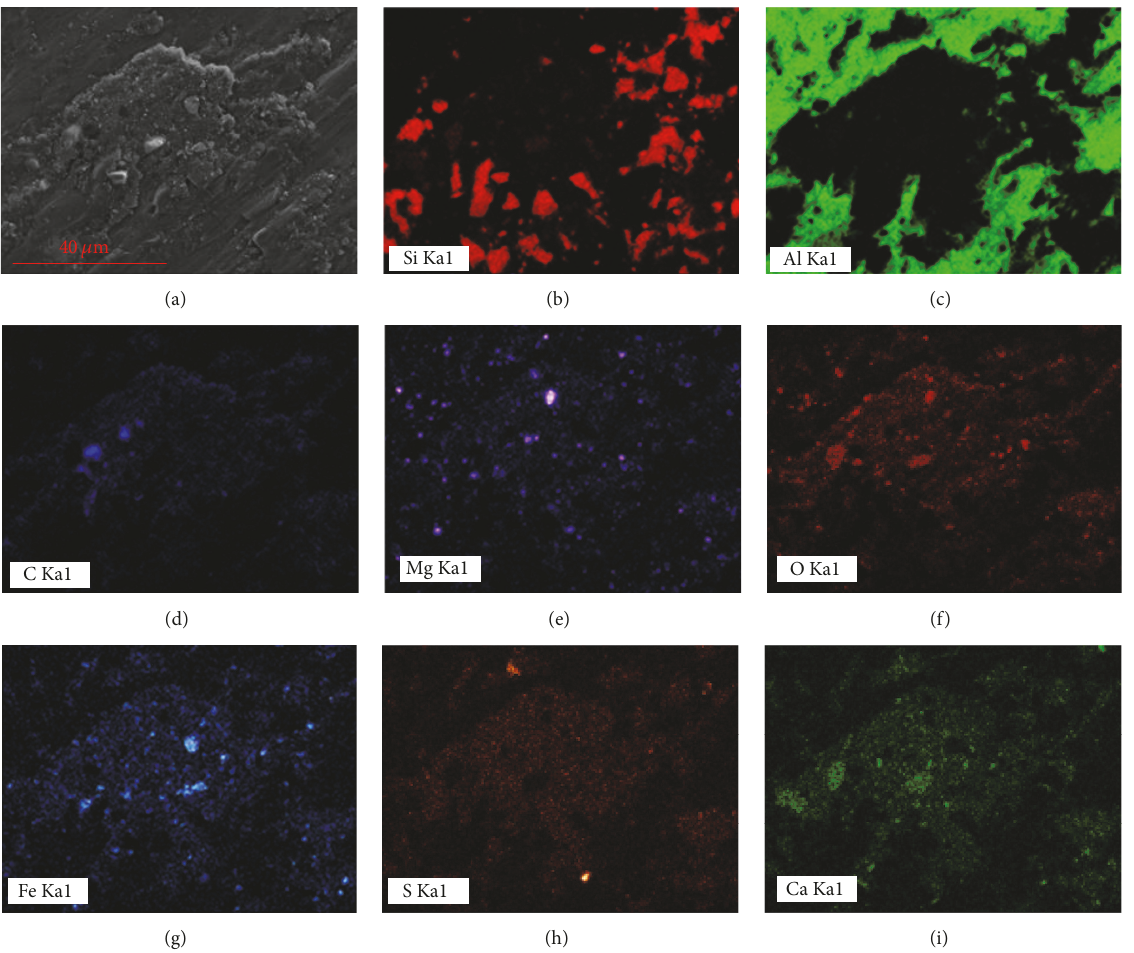
Figure 13: The surface element distribution of position P6 of composites specimen for the test of 100 ∘ C ∼ 200 ∘ C: (a) surface topography, (b) Si, (c) Al, (d) C, (e) Mg, (f) O, (g) Fe, (h) S, and (i)